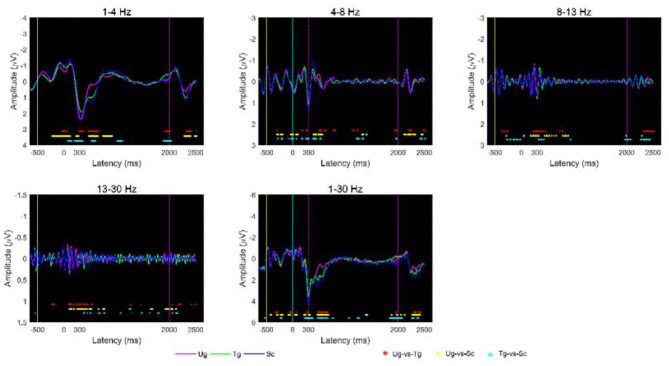
Average ERP at the group-level under different stimulus conditions. The yellow, cyan, and magenta vertical lines represent the end time of the symbol “+,” cup, and hand-cup interaction presentations, respectively. The magenta, blue, and green curves denote the average amplitudes across all subjects for the three stimulus conditions Ug, Tg, and Sc, respectively. The magenta dotted line denotes the start of the P300 component. The red, yellow and cyan “*” symbols at the bottom of the plots denote p < 0.05 according to t-tests, where the colors, respectively, correspond to Ug-vs-Tg, Ug-vs-Sc, and Tg-vs-Sc.